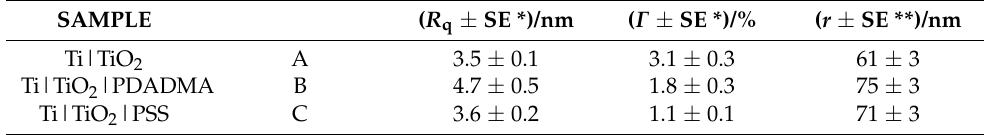
Table 1. RMS roughness ( R q ) and the proportion ( Γ ) and size ( r ) of protrusions on the surface of Ti/TiO 2 substrate before and after adsorption of PDADMA and PSS. SAMPLE Ti|TiO